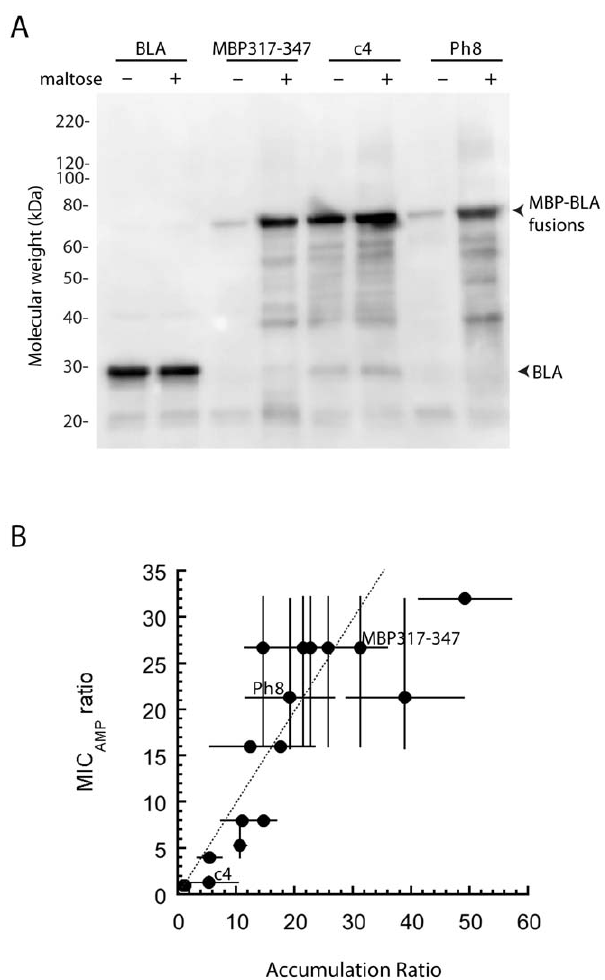
Figure 1. Characterization of phenotypic switches. (A) Western blot using anti-BLA antibodies of the soluble fraction of cells expressing BLA (lower arrow, , 30 kDa), MBP317-347, c4, and Ph8 (all upper arrow, , 70 kDa) cultured in the presence ( + ) and absence ( 2 ) of 5 mM maltose. (B) Correlation between the accumulation ratio ( + maltose/ 2 maltose), as measured by western blot, and the MIC Amp ratio ( + maltose/ 2 maltose) of cell expressing the 13 phenotypic switches, MBP317-347, c4 and BLA. The dotted line is y=x. Error bars represent the standard deviation (N=3).